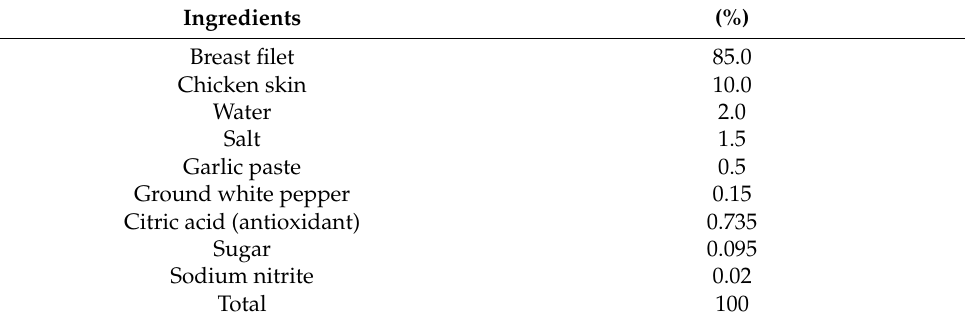
Table 1. Formulation used for sausages